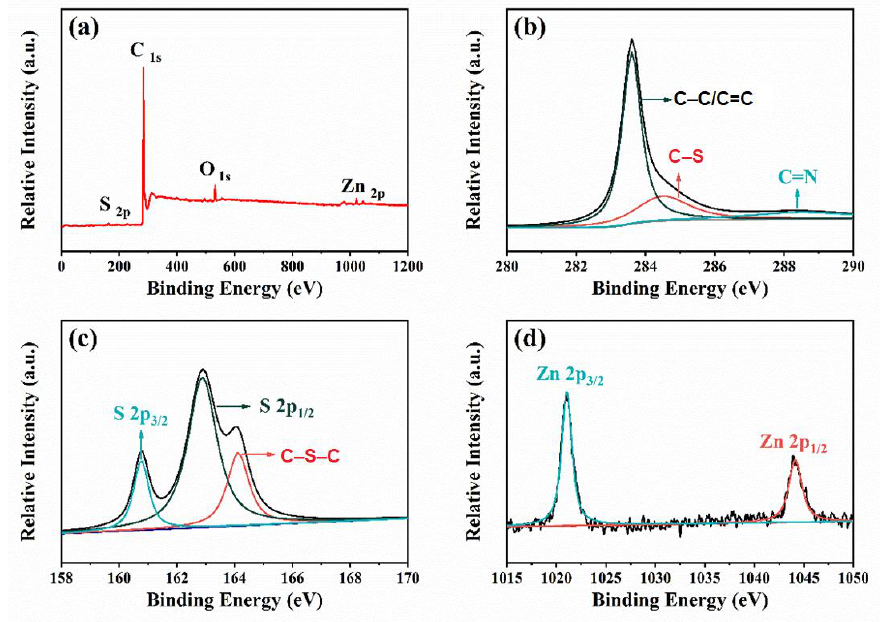
Figure 2. XPS spectra of ( a ) WTC-2; ( b ) C 1s; ( c ) S 2p and ( d ) Zn 2p.